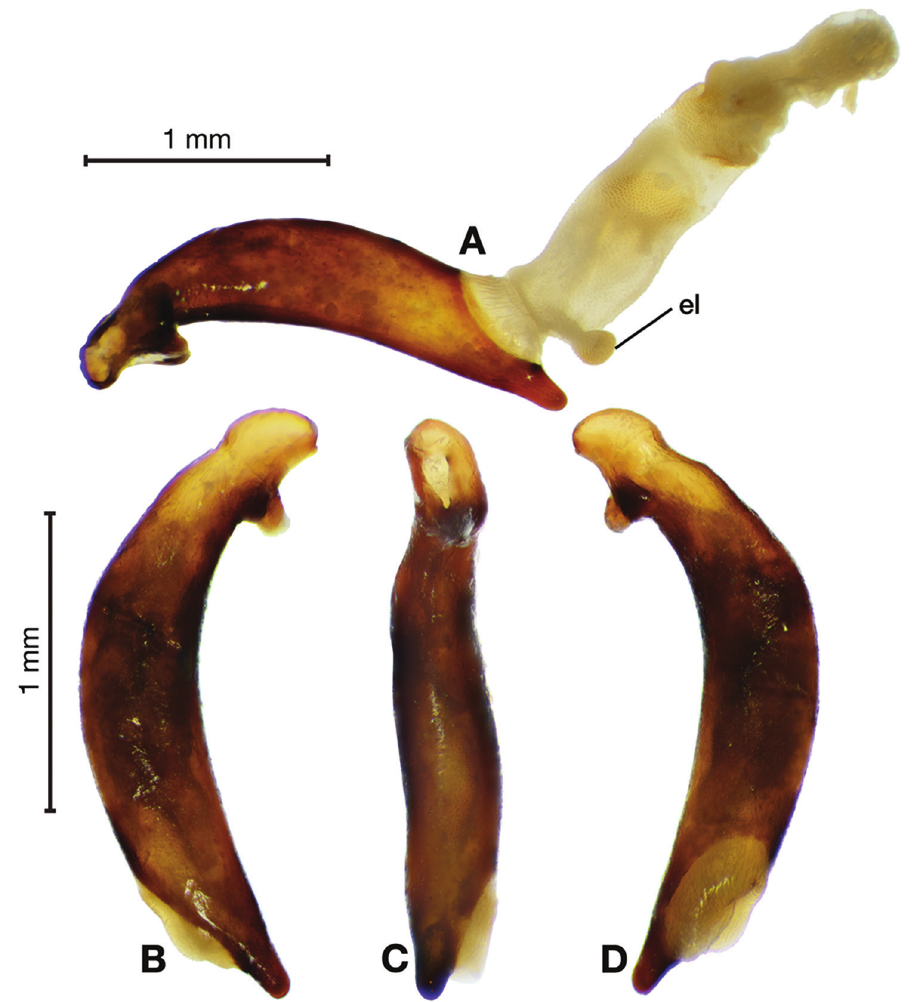
Figure 105. Digital images of male genitalia of Pericalus formosanus Dupuis. A left lateral aspect, en- dophallus everted B right lateral aspect C ventral aspect D left lateral aspect. Legend: el endophallic lobe. in interval 4, mid-length macula from interval 4 to interval 5 or 6, apical macula with small patch from interval 2 to 3 and small patch in interval 7; ventral surface rufo- piceous to piceous; legs rufo-brunneous, tibia darker. Microsculpture. Head with microsculpture almost isodiametric to isodiametric; pronotum with microsculpture shallow, somewhat transverse to transverse; elytra with sculpticells transverse, single row of isodiametric cells down center of each stria; ventral surface with transverse to almost isodiameteric microsculpture. Macrosculpture and pilosity . Dorsum of head and base of clypeus rugulose, surface with very fine, scattered, setigerous punctures, hardly visible at 50×; pronotum